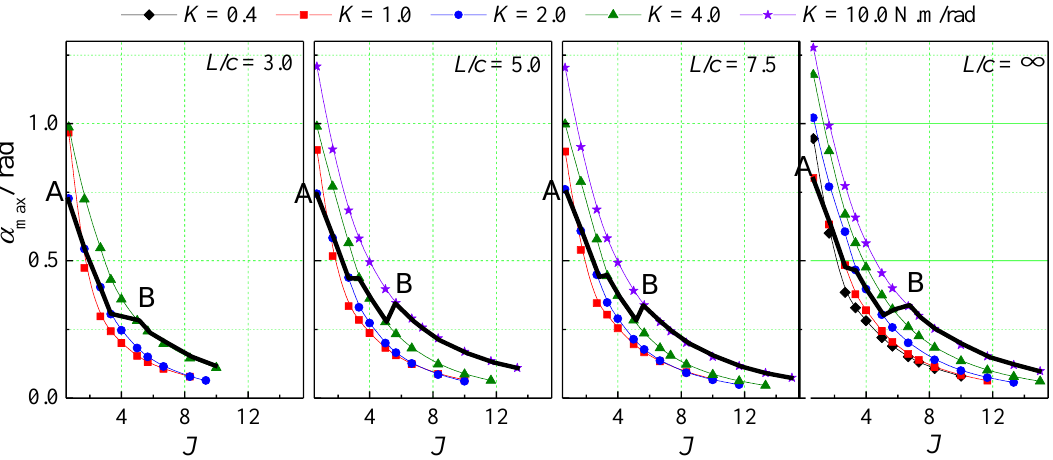
Figure 9. Maximum AoA with different spring stiffness and swing arm length. (black solid line is α max trajectory corresponding to the maximum thrust coefficient).